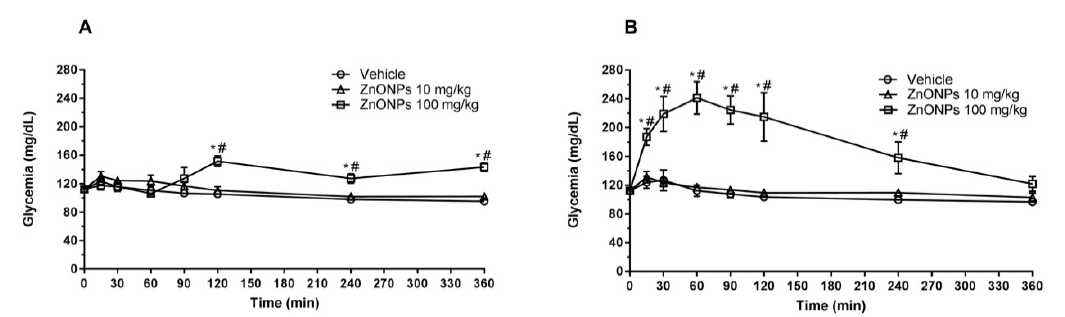
Figure 3. Short-term effects on glycemia of oral or intraperitoneal administration of ZnONPs in fasted diabetic rats. ( A ) Oral administration (p.o). ( B ) Intraperitoneal route (i.p). Vehicle (Sterile 0.9% sodium chloride solution). * significant in comparison to vehicle ( p < 0.05, n = 8 by group), # significant in comparison with group treated with 10 mg/kg.